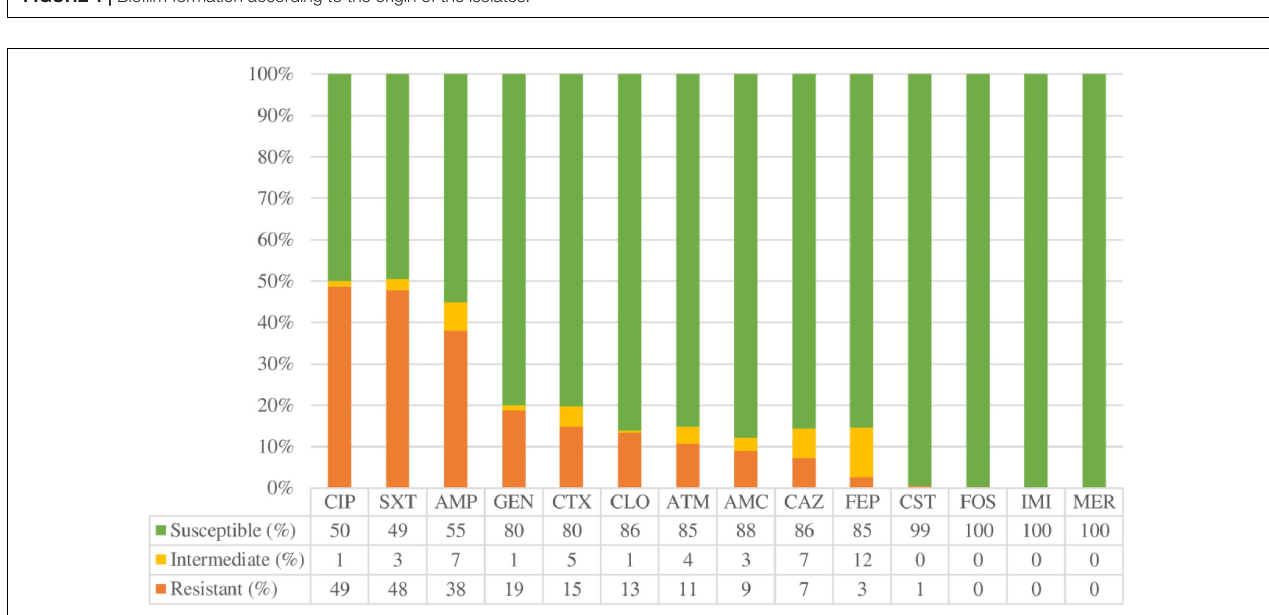
FIGURE 1 | Biofilm formation according to the origin of the isolates.